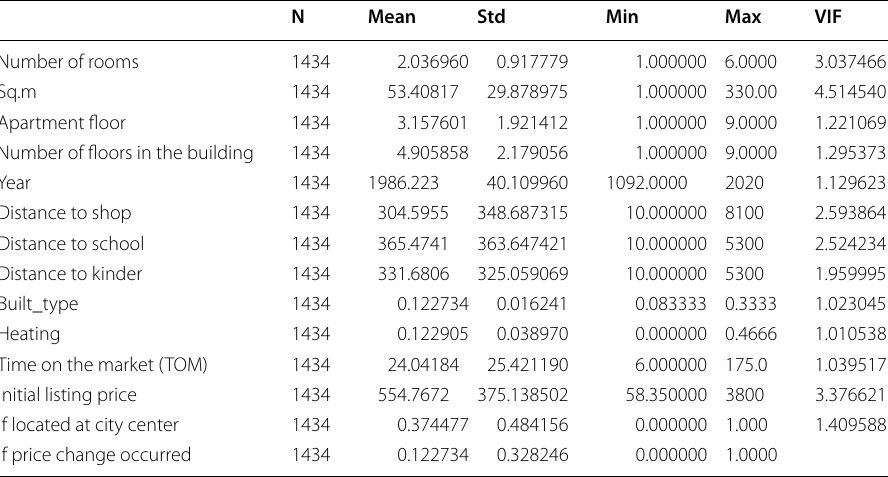
Table 1 Sample descriptive statistics for month August rent operations